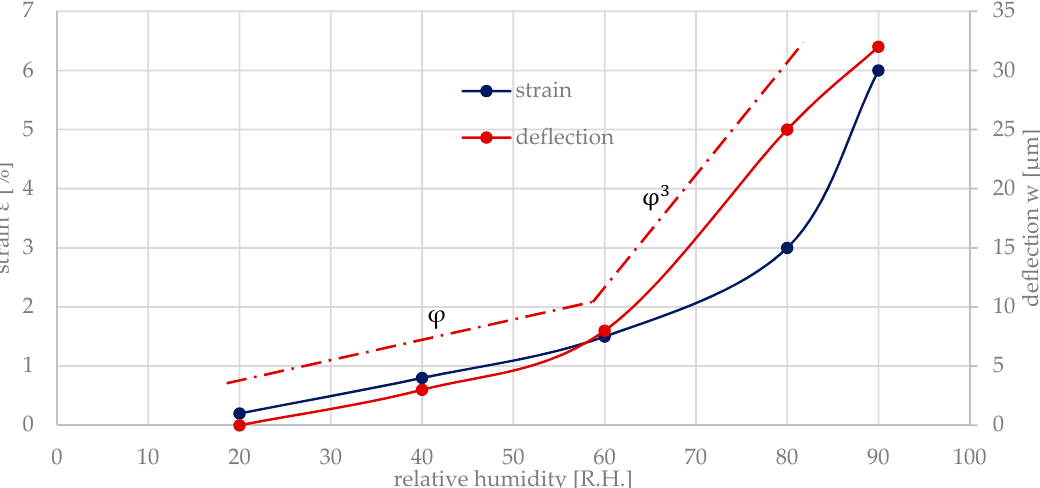
Figure 11. Strain ε in the hydrogel as a function of the relative humidity and the deflection w with a linear and cubical term of the angle ϕ 3 (adapted from Reference [7]).